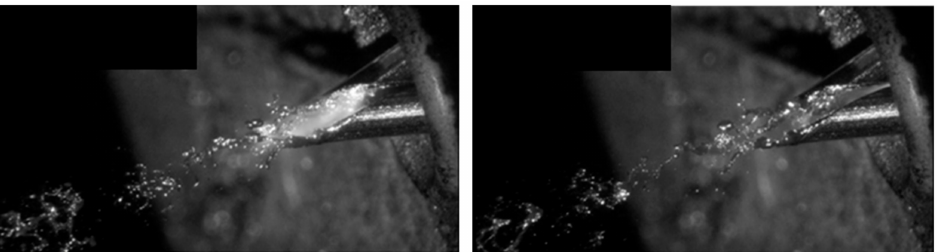
Figure 4. Particle formation during wire arc spraying with direct current at time ( left ): t = 35.95 ms, ( right ): t = 36.00 ms.